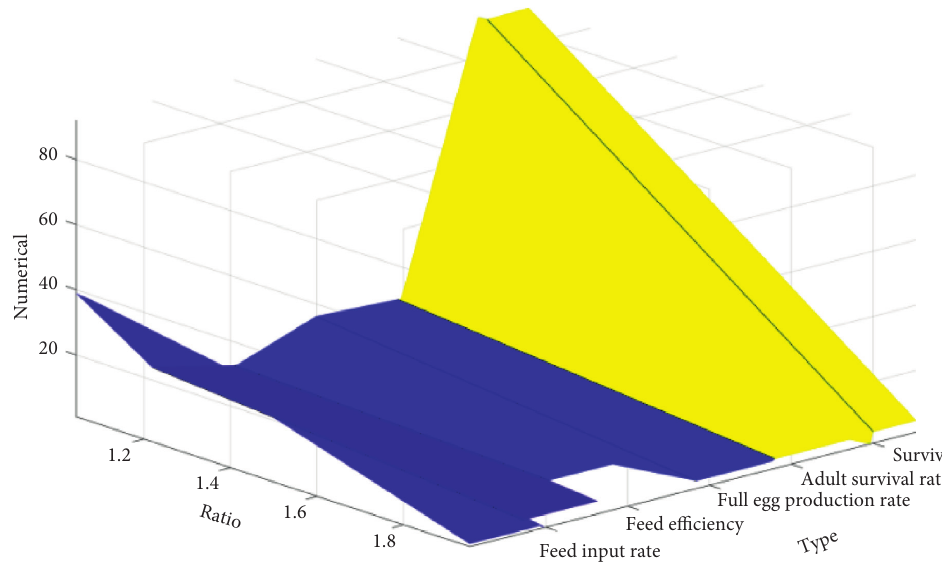
Figure 4: Specific data of BFA preparation added in